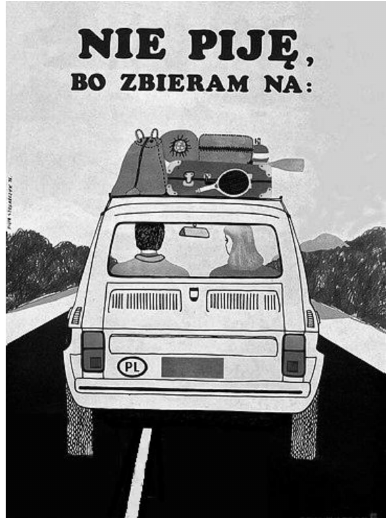
Figure 5. Example of social advertising in the PRL which reads: I don’t drink because I’m saving money for my new car